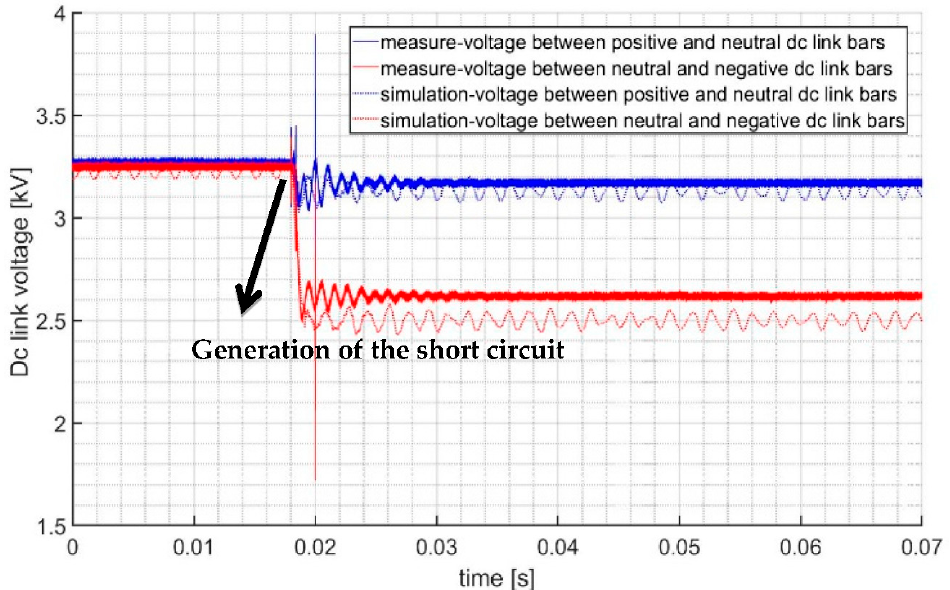
Figure 13. Voltages on the dc link, obtained from the simulation of the short circuit, without considering the detachment of the flexible connection, and the voltage measurements acquired in the test.